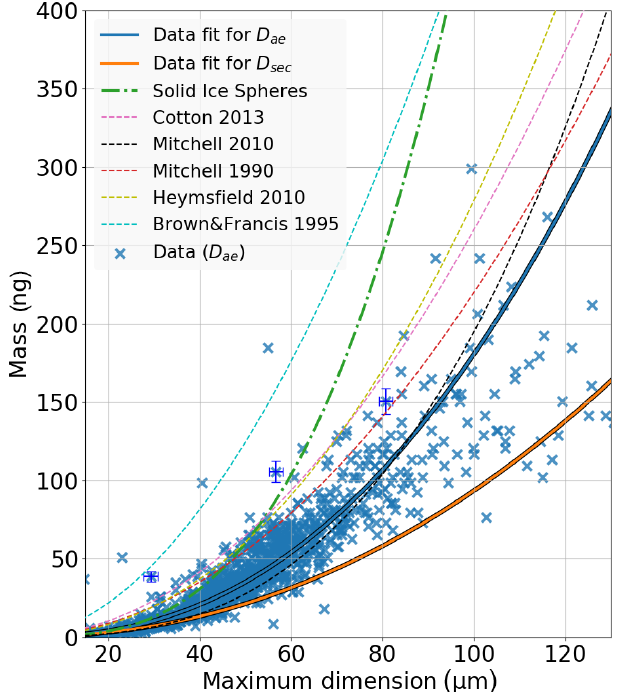
Figure 5. Ice crystal mass as a function of maximum dimension from the present ICC experiments ( N = 1207, D ae in blue, best fit as solid blue line; D sec best fit as orange solid line). Parame- terizations from literature are plotted by dashed lines. The green dash-dotted line shows the mass of a spherical object with density ρ ice = 0 . 9184kgm − 3